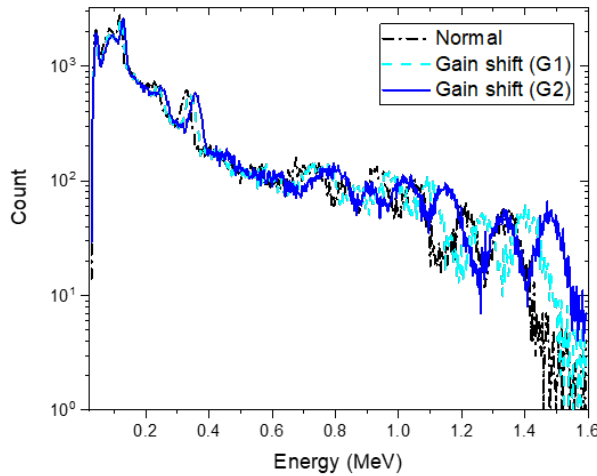
Figure 12. Experimental spectrum composed of Eu-152 and Eu-154 sources buried in sand at depths of 3 cm and 6 cm, respectively (black das-dotted line) and its shifted spectra (sky-blue dashed line and blue solid line) having different magnitudes of the shift due to calibration drifts. The spectra were acquired for 30 s.